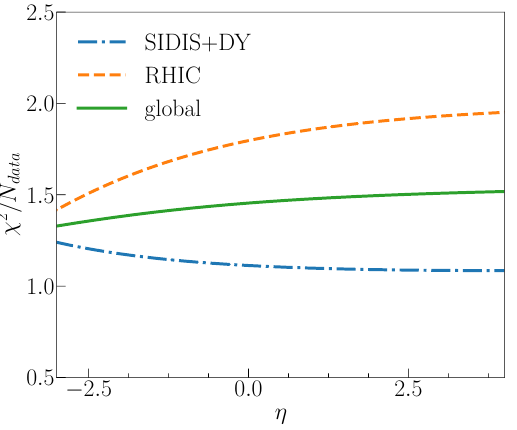
Figure 14 . χ 2 /N data profile for the η parameter. To generate this plot, we use the parameter values from section 4.2 and vary the parameter η